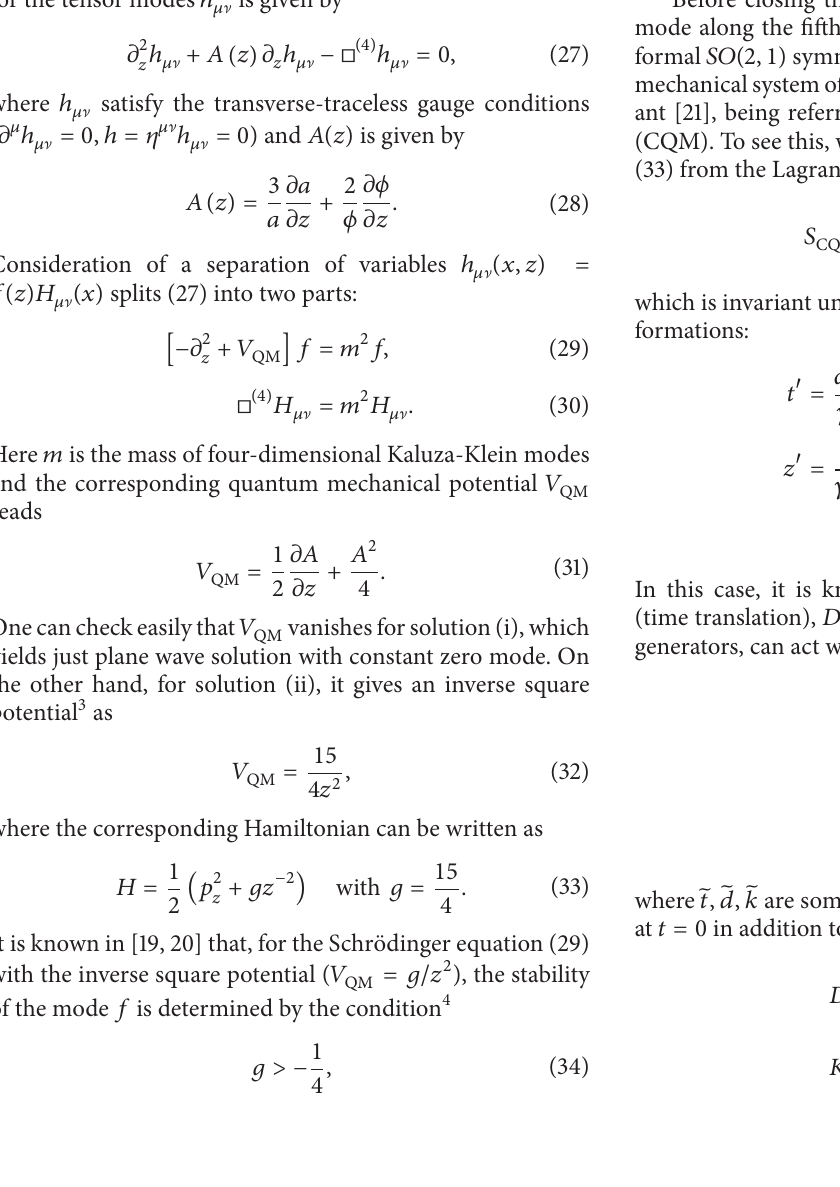
where a new variable 𝑧 given in a conformally flat metric